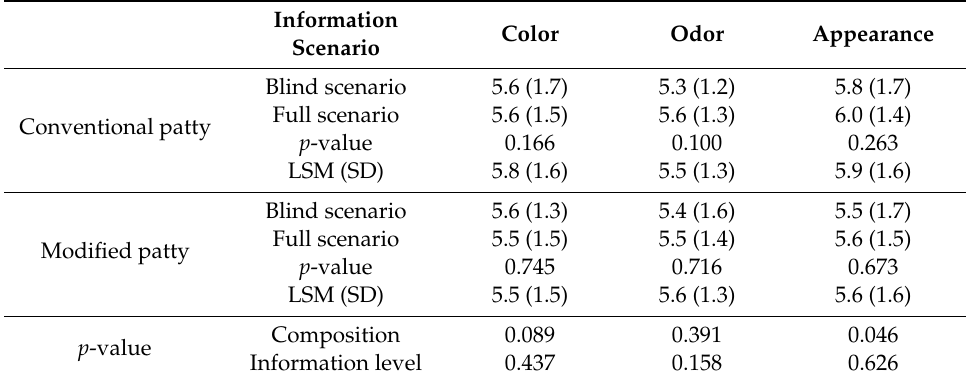
Table 2. Least square means (LSM), standard deviation (SD), and p -values of consumer scores for sensory descriptors of raw patties (conventional, and modified with olive and linseed oil mixture and vitamin D 3 ) on the di ff erent information levels.